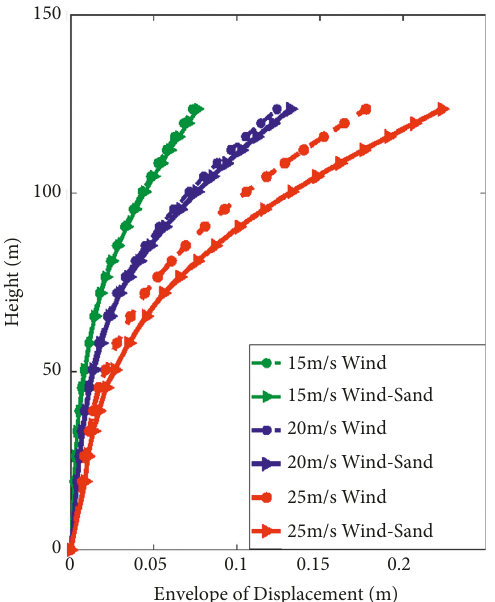
Figure 11: Displacement envelope.